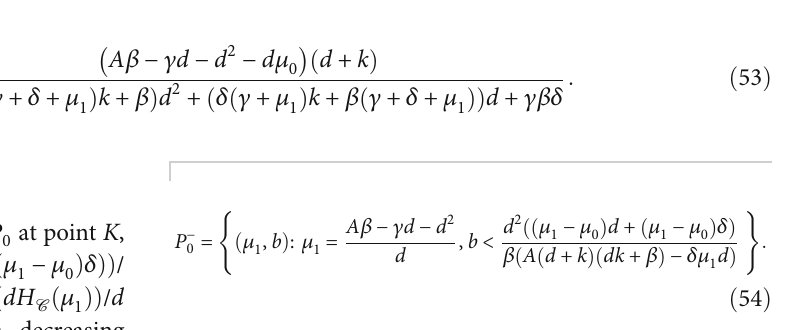
C =0 de fi nes one branch of hyperbola P